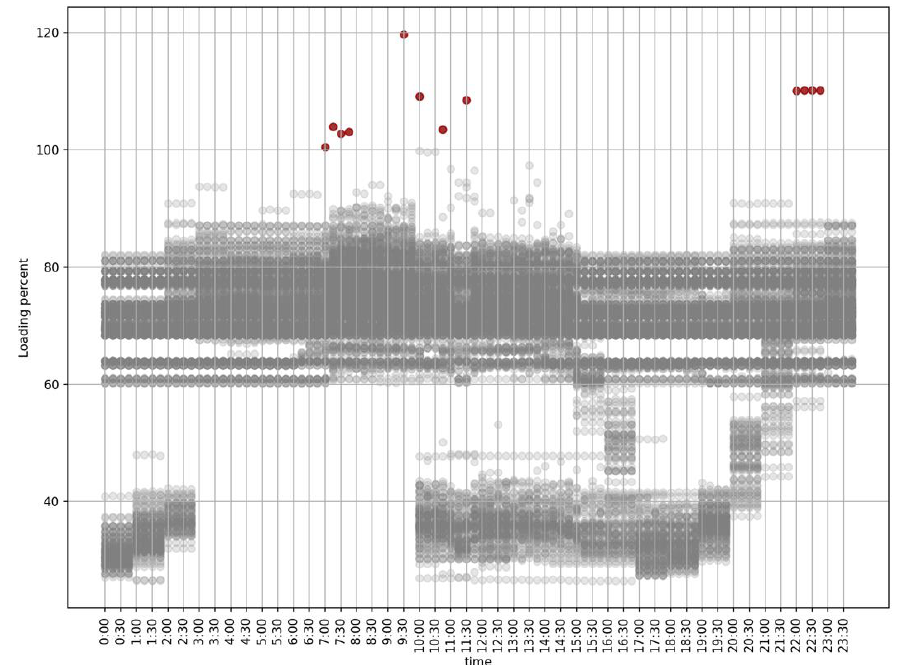
Figure 2. The results of power flow simulations in the form of loading percentage on line 14 for each 15-min interval.